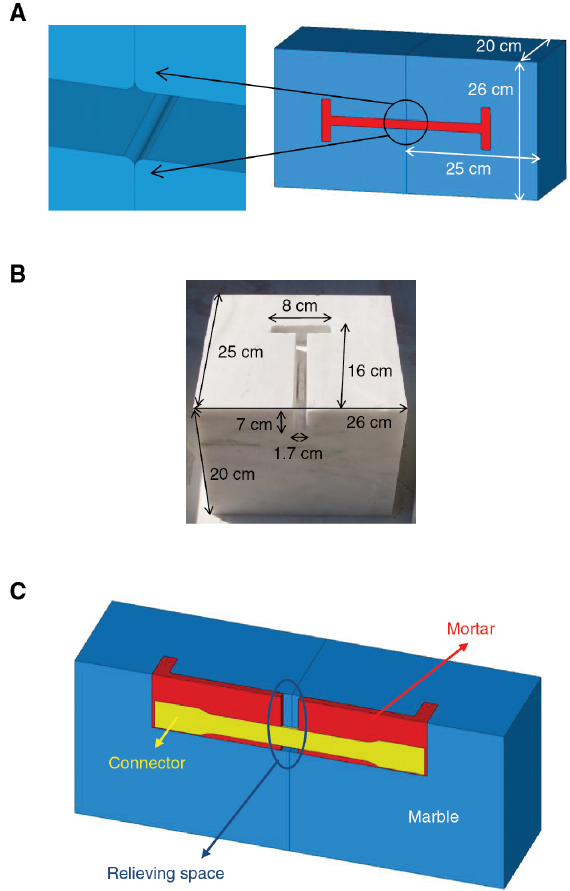
Figure 3: (A) The outer dimensions of the epistyles of the numerical model and structural details at the interfacial plane of the two marble blocks. In the enlarged figure (left), the connector and the filling material are removed for clarity. (B) The dimensions of the marble volumes and the groove. (C) Half of the model with the relieving space ( “ cut ” along the length of the